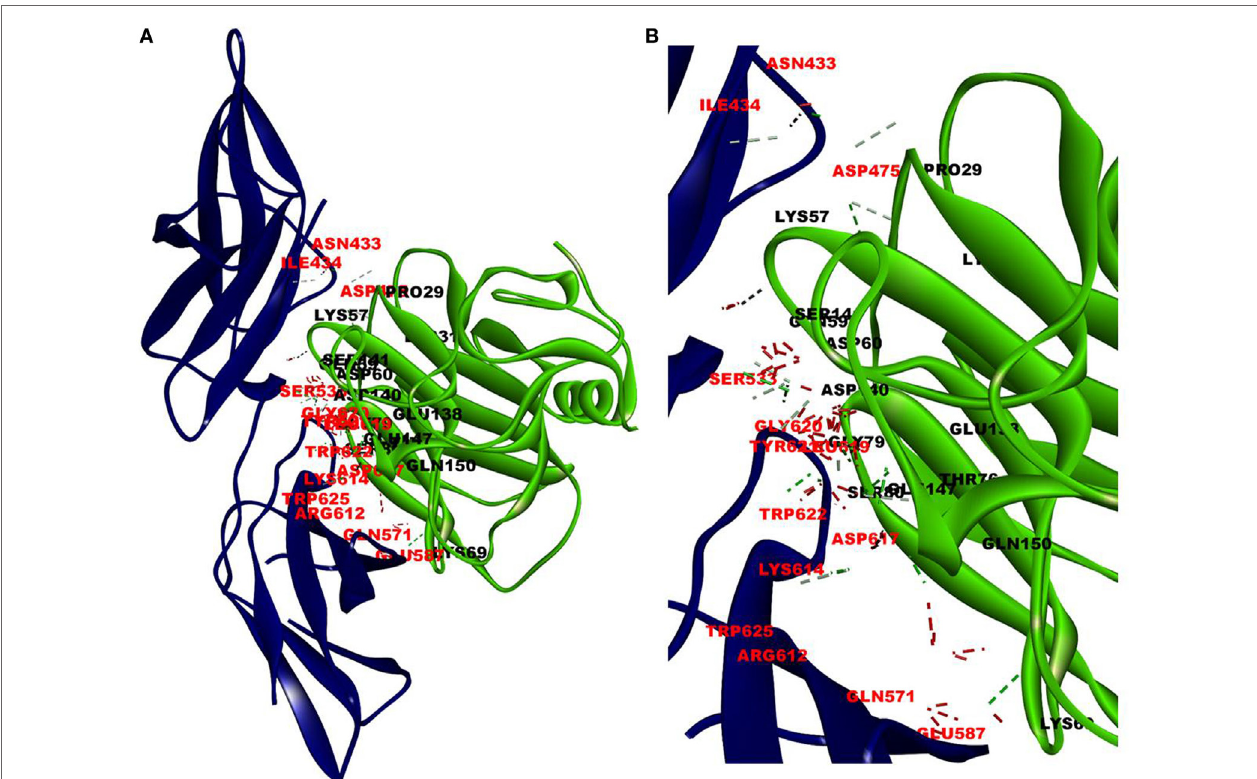
FigUre 1 | Docking of C-reactive protein (CRP) to leptin receptor. Protein–protein docking was done by employing Z Dock Protocol in Discovery Studio as described in the text. The image of the pose with the best Z -rank score in the largest cluster is shown in (a) leptin receptor, PDB ID 3V6O, (CRH2 domain), (deep blue) docked (blind) with CRP monomer, PDB Id 1GNH, (single chain) (green) and (B) enlarged image of docked amino acid skeleton.